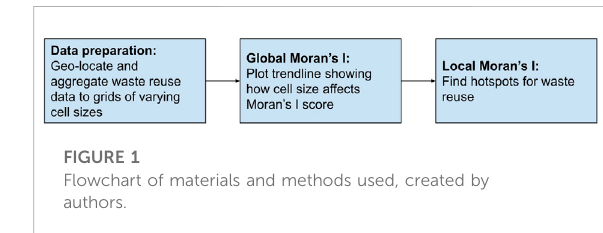
FIGURE 1 Flowchart of materials and methods used, created by